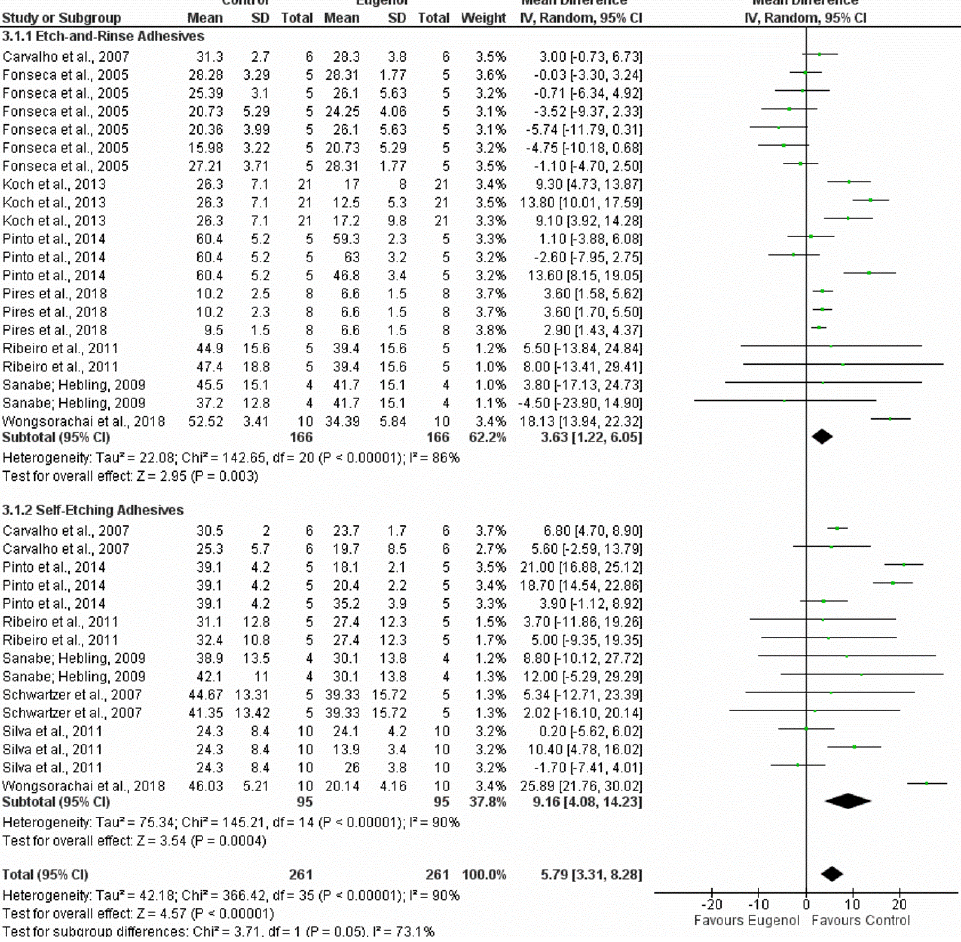
Figure 3. Forest plot of global and subgroups (etch-and-rinse (ER) or self-etch (SE) adhesive system) meta-analyses. The bond strengths of adhesive systems/resin-based restorative materials to coronal dentin after contact with eugenol-based materials and without contact were compared.